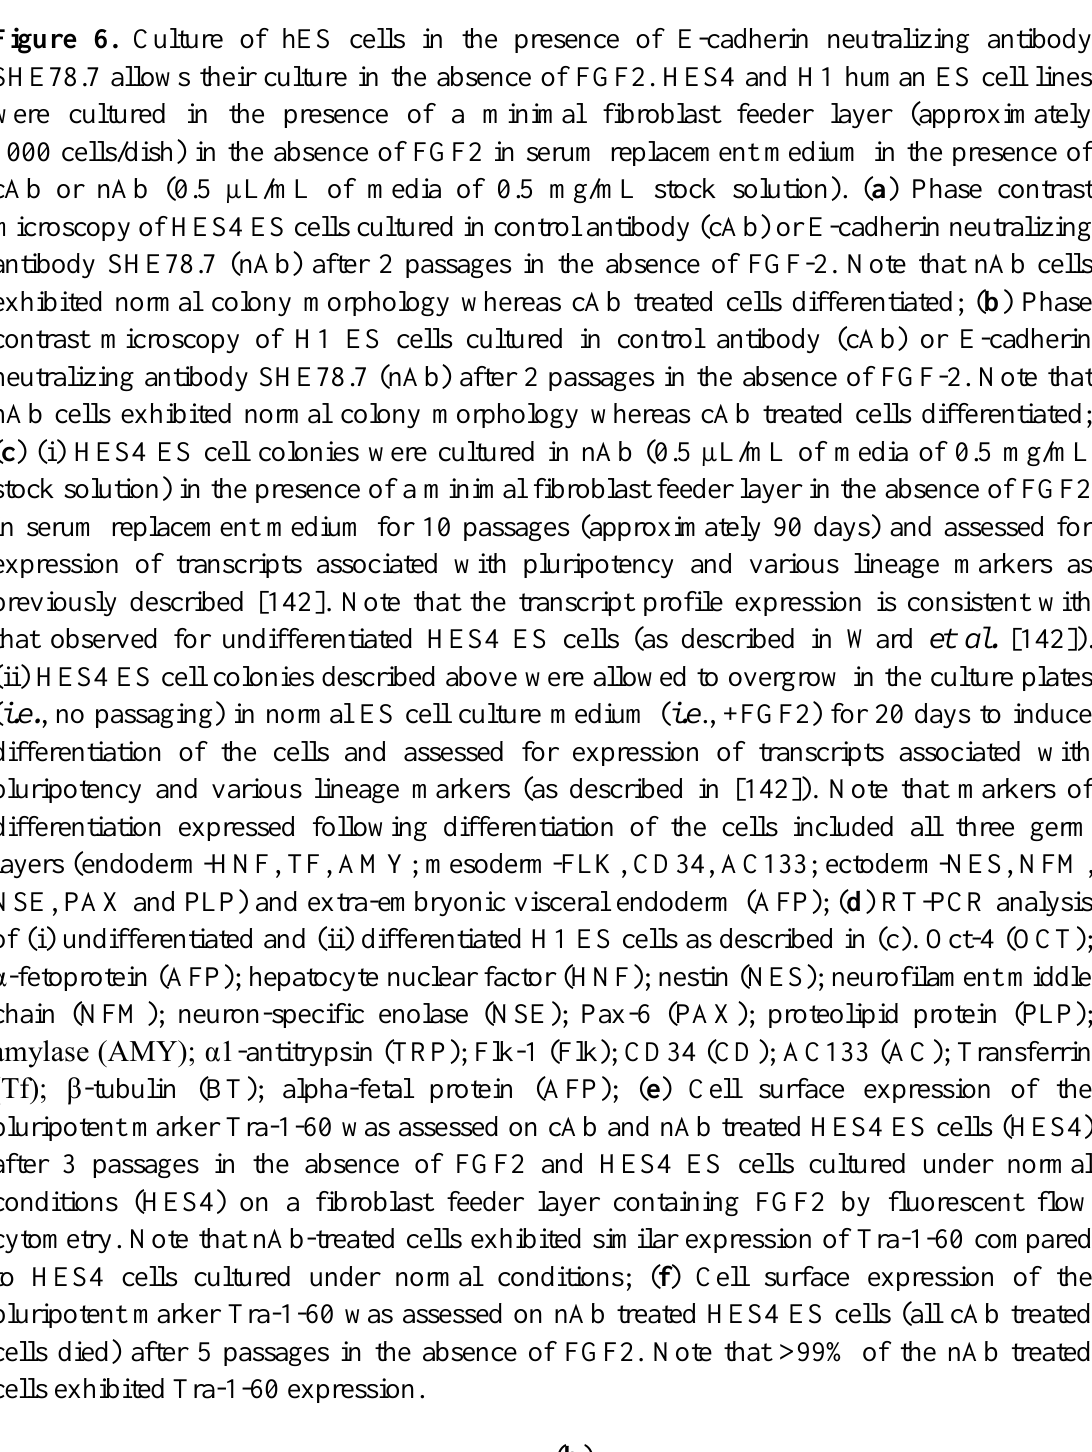
Figure 6. Culture of hES cells in the presence of E-cadherin neutralizing antibody SHE78.7 allows their culture in the absence of FGF2. HES4 and H1 human ES cell lines were cultured in the presence of a minimal fibroblast feeder layer (approximately 1000 cells/dish) in the absence of FGF2 in serum replacement medium in the presence of cAb or nAb (0.5 µL/mL of media of 0.5 mg/mL stock solution). ( a ) Phase contrast microscopy of HES4 ES cells cultured in control antibody (cAb) or E-cadherin neutralizing antibody SHE78.7 (nAb) after 2 passages in the absence of FGF-2. Note that nAb cells exhibited normal colony morphology whereas cAb treated cells differentiated; ( b ) Phase contrast microscopy of H1 ES cells cultured in control antibody (cAb) or E-cadherin neutralizing antibody SHE78.7 (nAb) after 2 passages in the absence of FGF-2. Note that nAb cells exhibited normal colony morphology whereas cAb treated cells